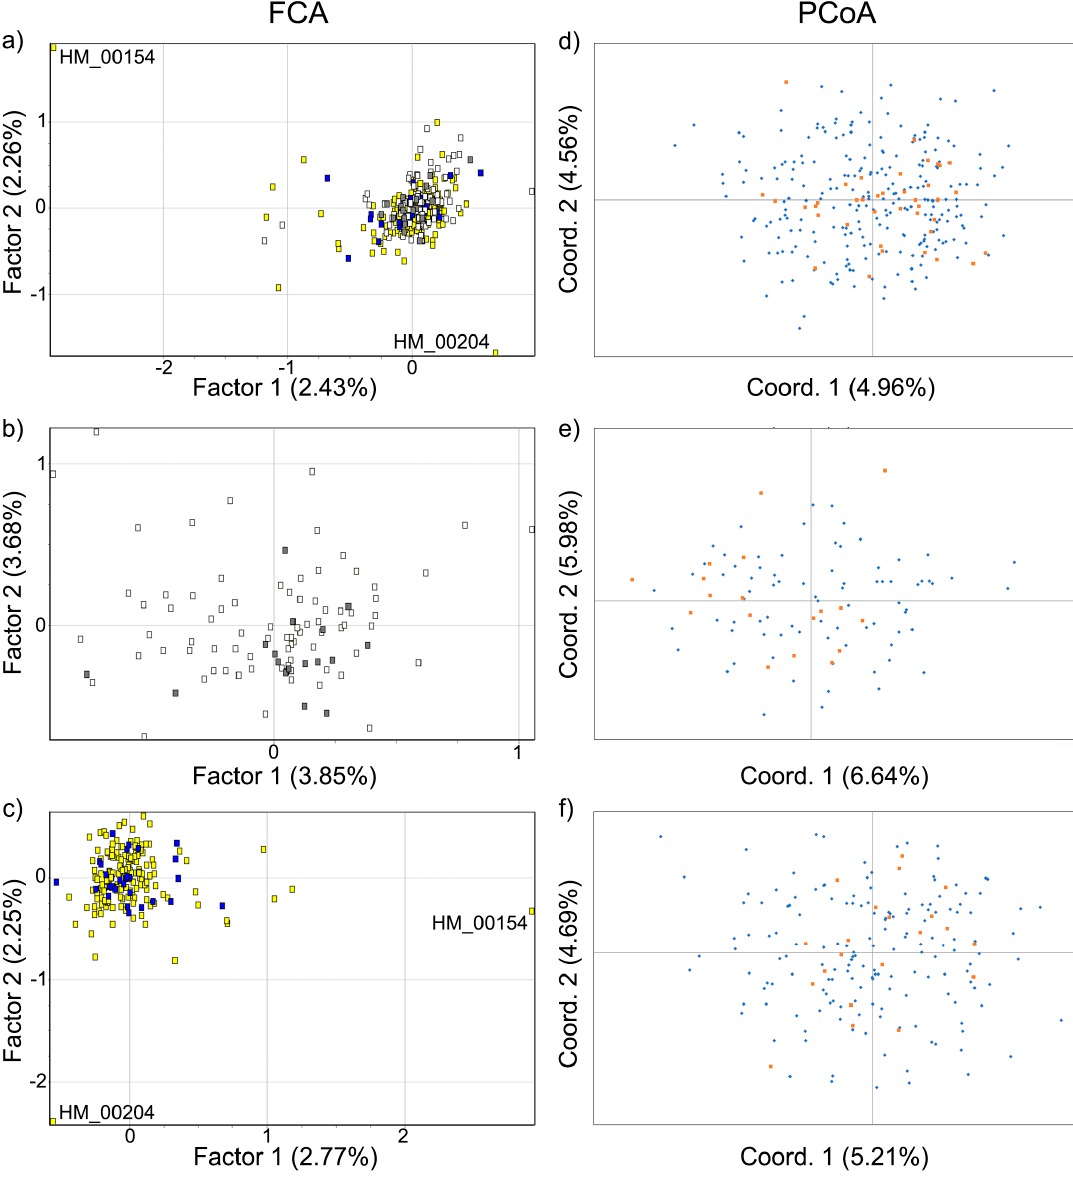
Figure 3. Factorial correspondence analysis (FCA) and principal co-ordinates analysis (PCoA) two-dimensional plots of microsatellite variation of elephants in the APNR and in KNP. ( a ) and ( d ): all individuals; ( b ) and ( e ): all females; and ( c ) and ( f ): all males. In the FCA plots, APNR males are in yellow, KNP males are in blue, APNR females are in white and KNP females are in grey. The two outlying males are labelled. In the PCoA plots, blue represents individuals from the APNR and orange represents individuals from KNP. In the FCA and PCoA plots, respectively, the percentage of the total inertia accounted for by each of the first two factors and the percentage of variation explained by each of the first two coordinates are given in parentheses.